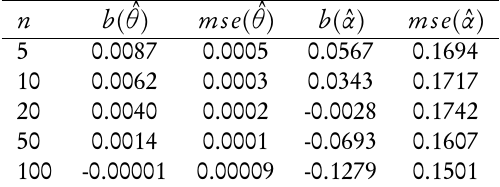
Bias and mean square error of the m.l.e.’s ( ˆ θ , ˆ α ) , for the power negative binomial distribution {